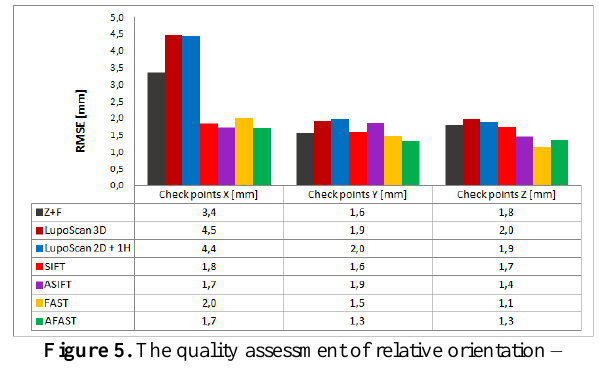
Figure 5. The quality assessment of relative orientation – RSME on marked check points